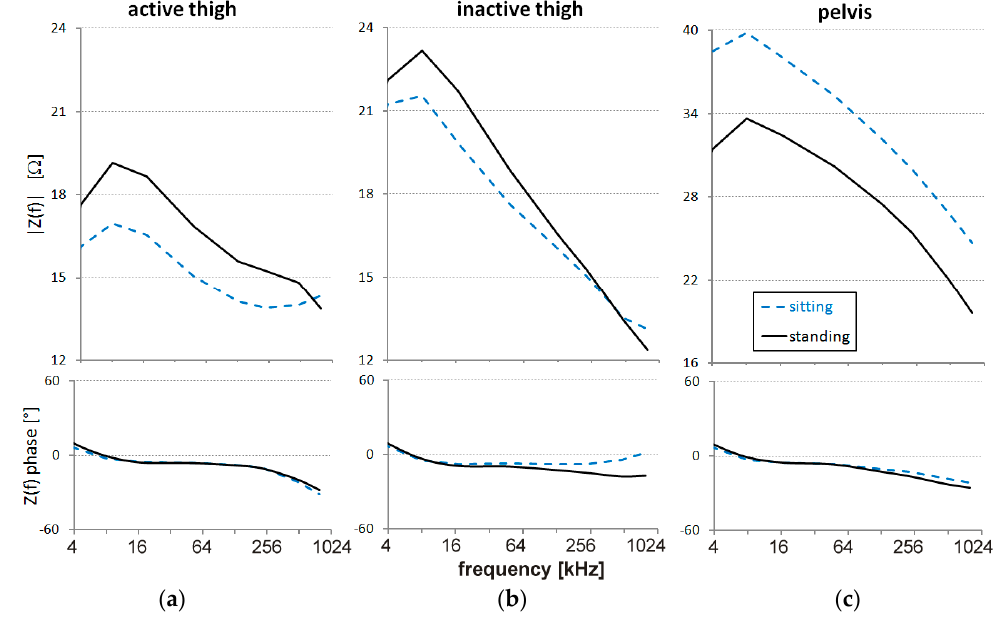
Figure 8. Modulus and phase of Z (f) in sitting and standing positions during recovery from exercise: ( a ) active thigh; ( b ) inactive thigh; ( c ) pelvis.